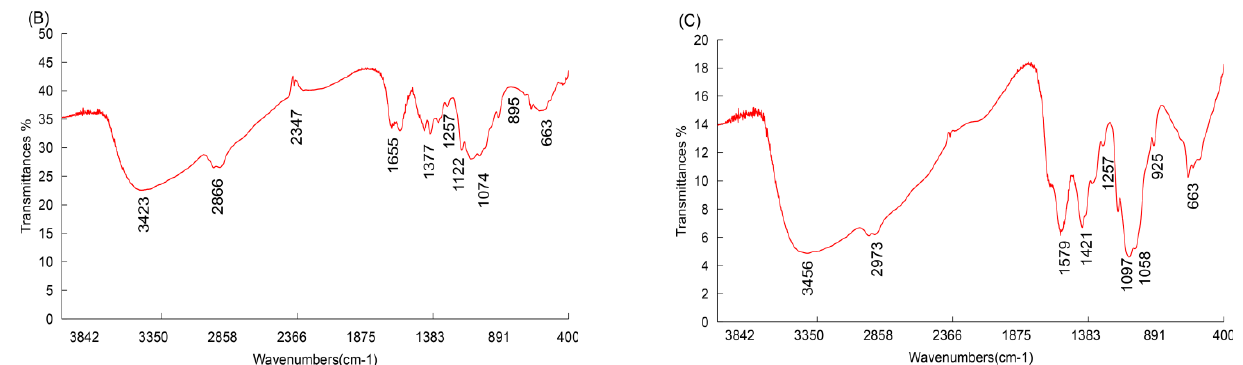
Figure 2. FT-IR spectra of mannose-modified CS. The IR spectrum of the sample powder was analyzed using the potassium bromide pellet method in an IR spectrophotometer. The data were determined between 4000 and 400 cm − 1 . The IR characteristics of mannose (MAN) ( A ), CS ( B ), and MAN-modified CS ( C ) are illustrated.